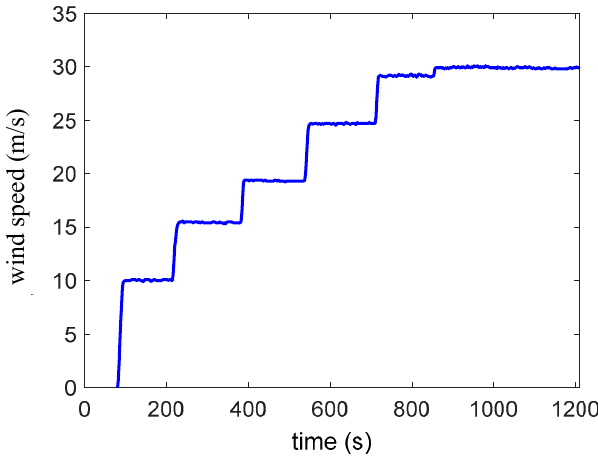
Figure 10. Measured wind speed (from Kestrel) versus time for different revolutions per minute (RPM) values in the fan.